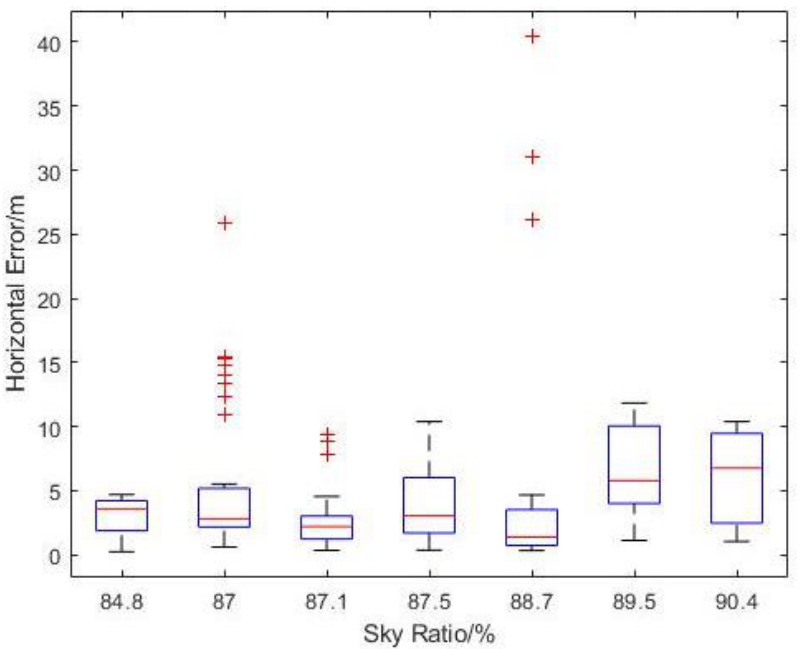
Figure 16. Boxplot of Measured Horizontal Error vs. Sky Ratio at Carpark F.